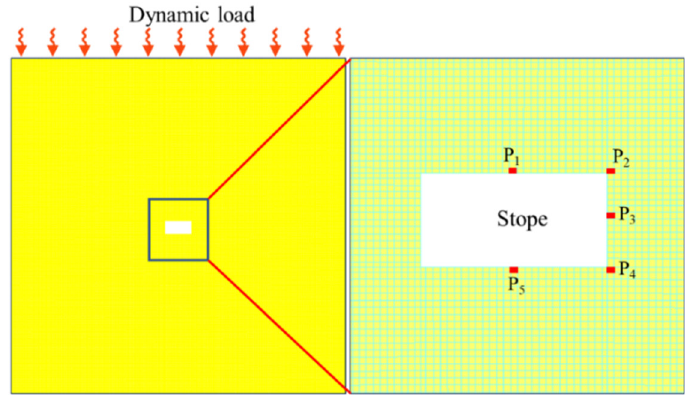
Figure 7. Explicit solution model I (top dynamic loading).